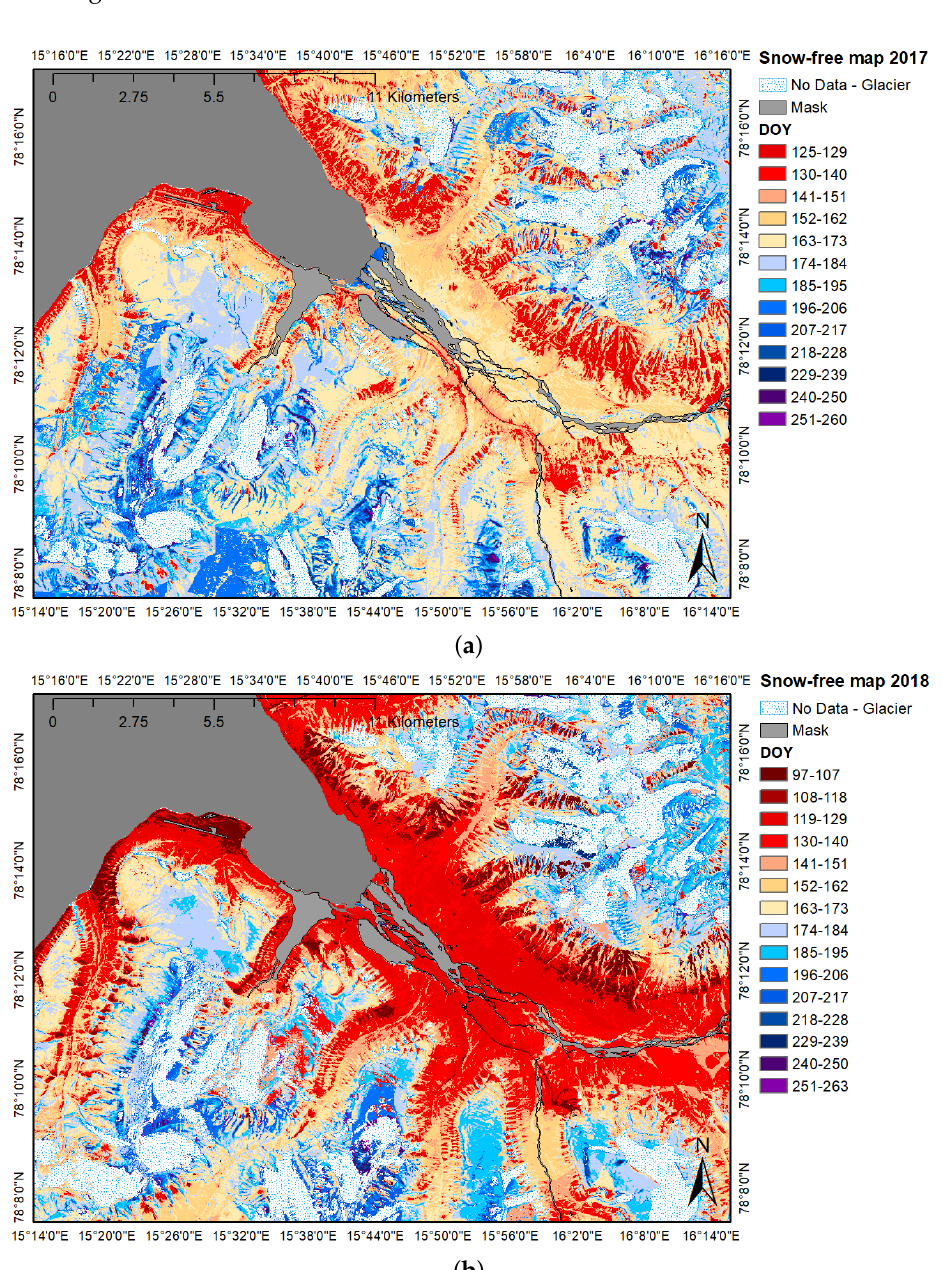
Figure A2. Snow-free maps for the years 2017–2018 (Period May-September). Each colour is matched by a period of 10 days expressed in DOY. ( a ) 2017 and ( b )